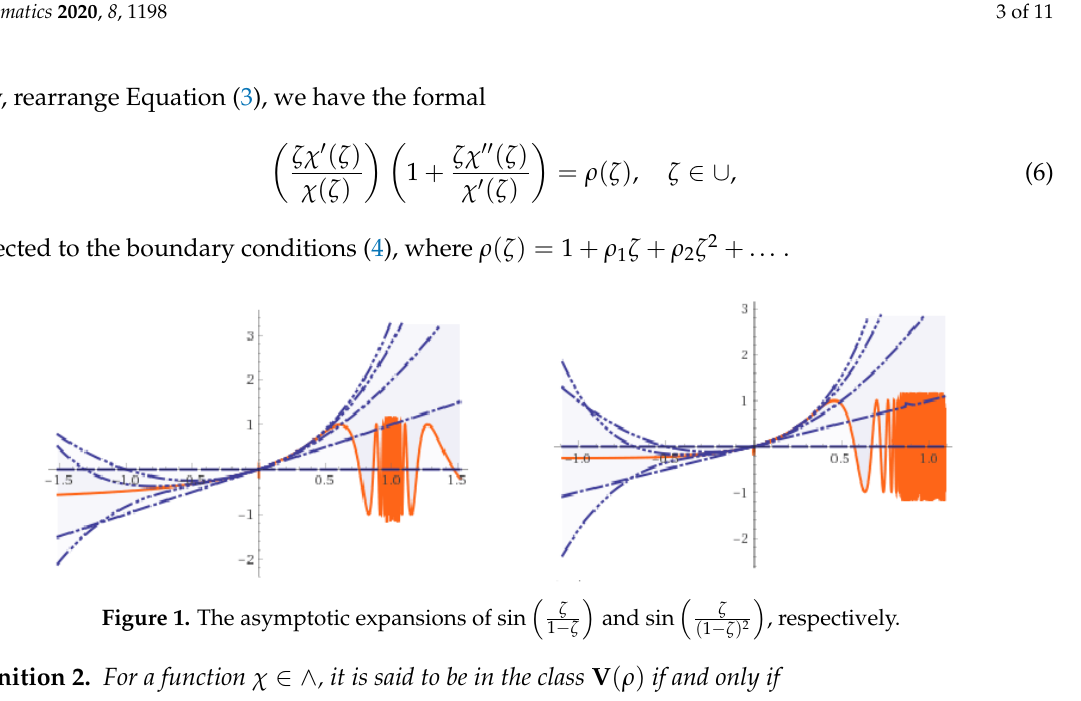
(cid:16) (cid:17) ζ , ( 1 − ζ ) 2